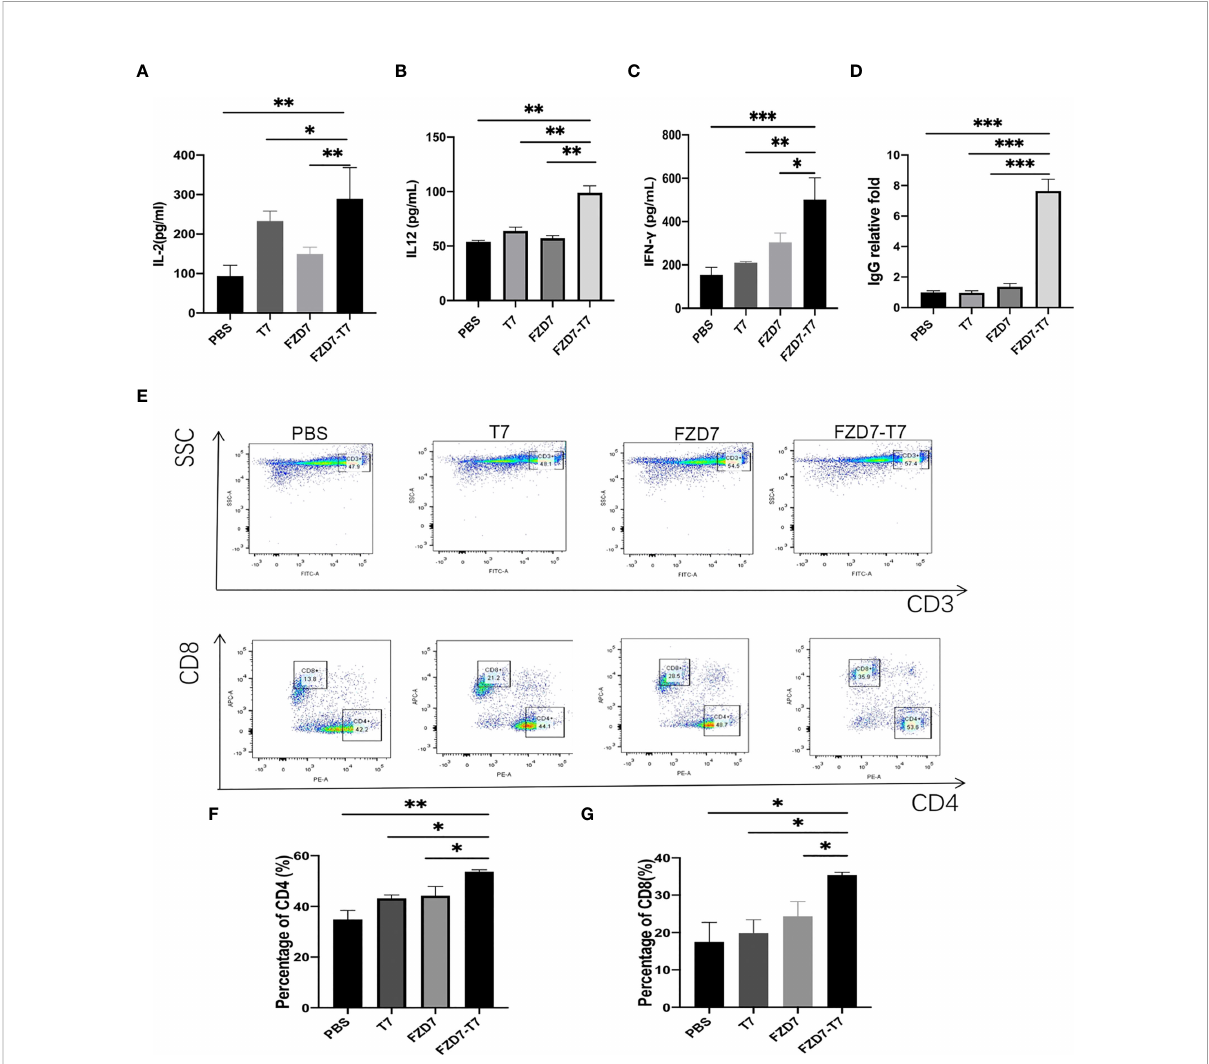
FIGURE 4 Assess cytokine, antibody, and T cell responses in vivo. (A) IL-2. (B) IL12. (C) IFN- g . (D) ELISA of speci fi c antibody content of FZD7 peptide after different vaccine stimulation. (E) Flow cytometric lymphocyte isolation. (F) The ratio of CD3 + /CD4 + T cells was detected. (G) CD3 + /CD8 + T cells ratio (*P < 0.05, **P <0.01, ***P <